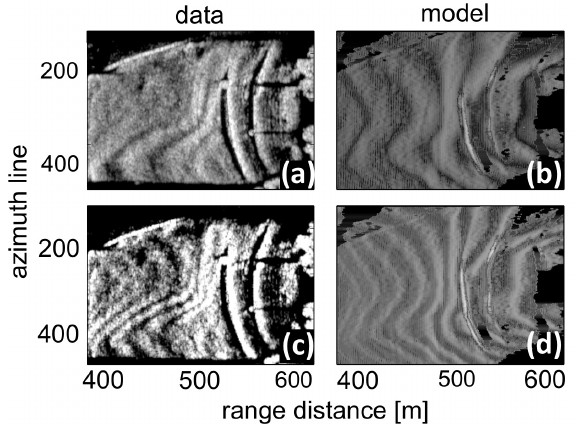
Figure 8. Measured and modelled MPI in the Hönggerberg test site with different antenna elevations. The upper rows ( a , b ) were measured and modelled with an antenna elevation of 1 m, while the lower rows ( c , d ) correspond to an antenna height of